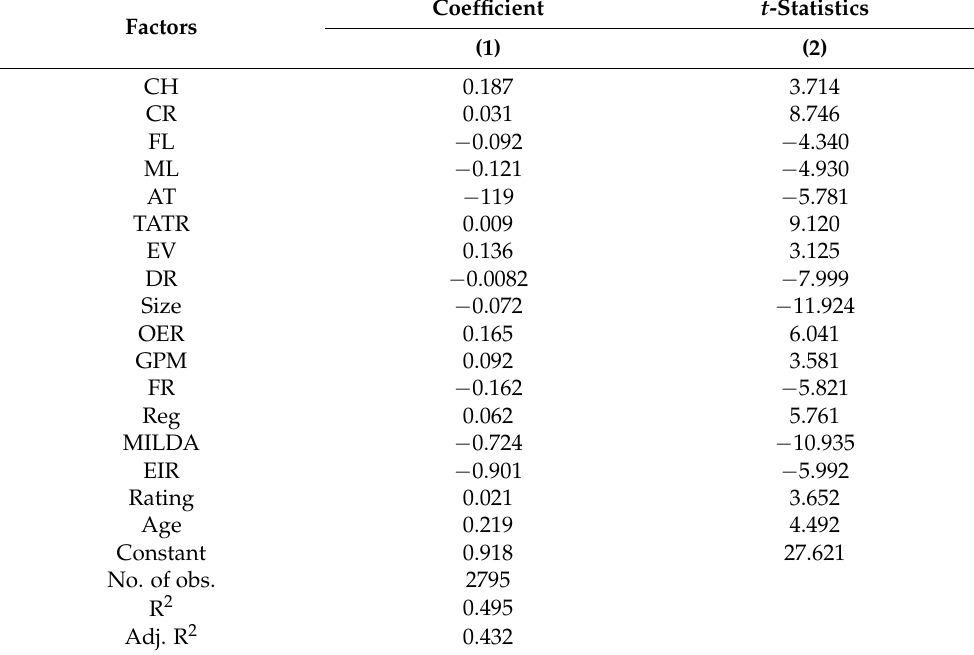
Table 6. Estimation of important predictors using stepwise regression